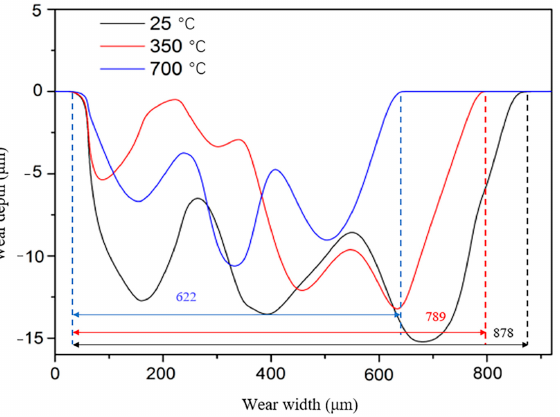
Figure 16. The wear cross-section trajectory curve of alloying coating at different temperatures.